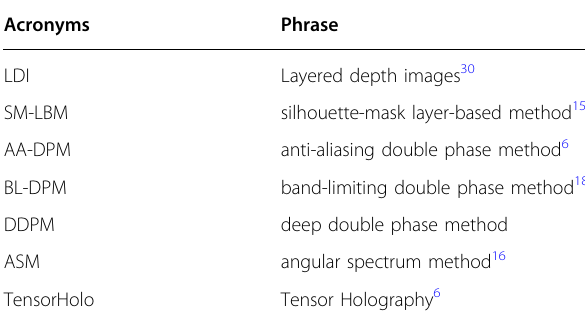
Table 1 Acronyms used in this